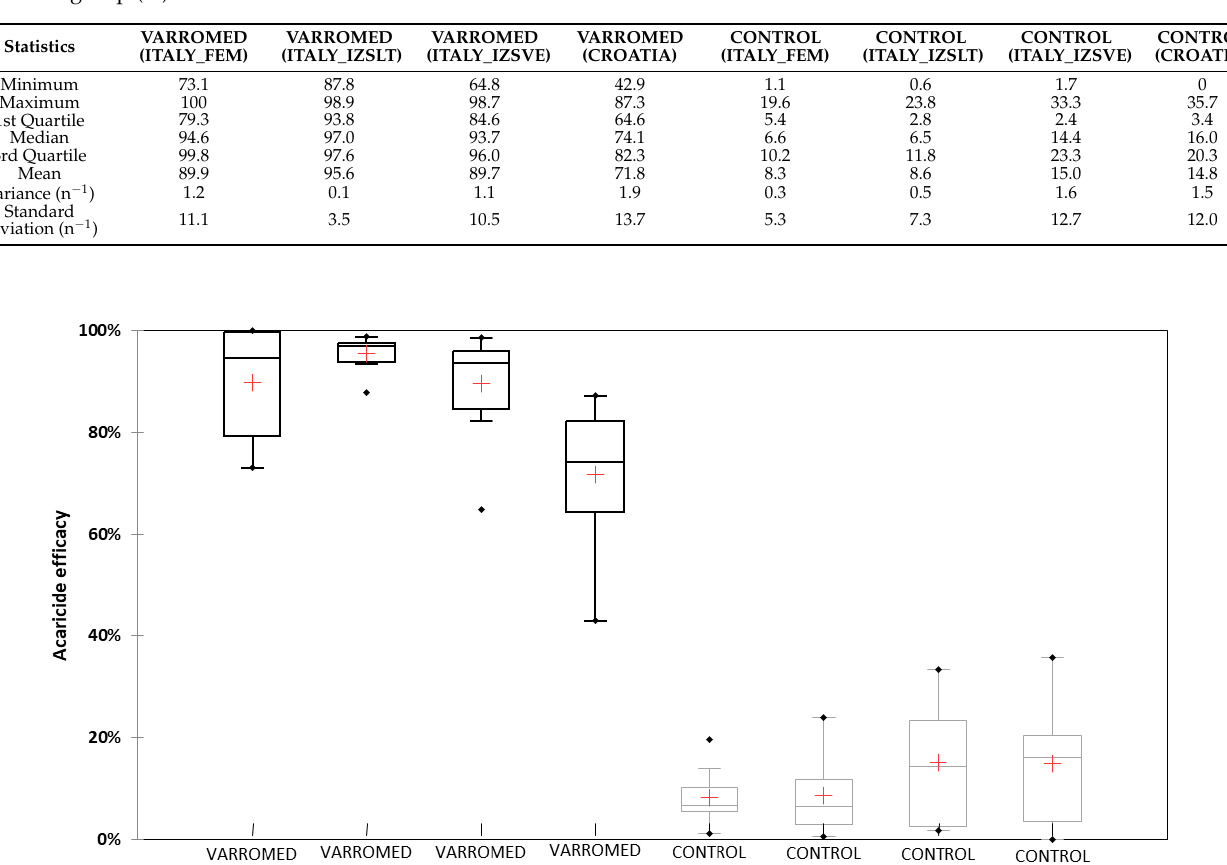
Table 5. Acaricide efficacy recorded during the summer/autumn trial in the apiaries and relative mite fall during the same period in the control group (%).